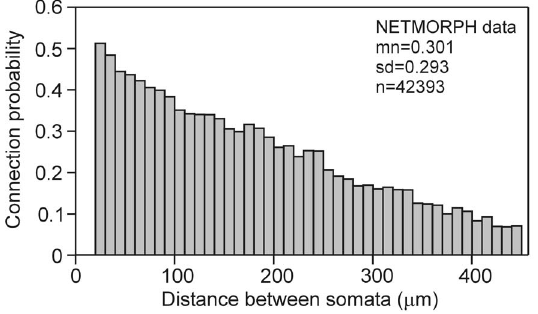
Figure 7. Connection probability between neurons as a function of Euclidean distance between their somata. Note that the minimum intersoma distance with which the network was created was 20 m